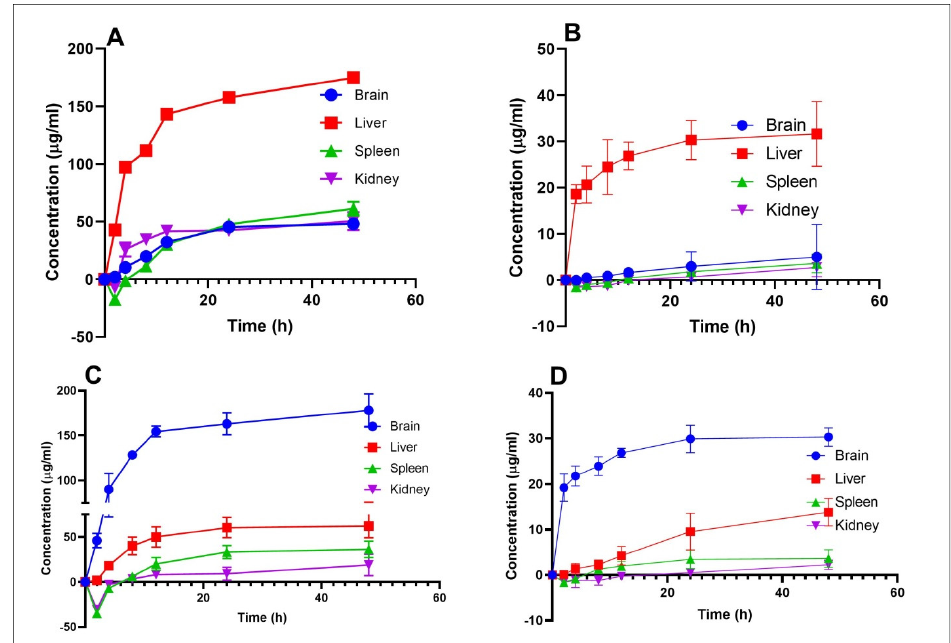
Figure 11. MeHCl and TMPS Concentration in major organs after intraperitoneal administration at 30mg/kg body weight (1:3 molar ratio) ( A ) MeHCl PD ( B ) TMPS PD ( C ) MeHCl SLN ( D ) TMPS SLN. Data are represented in mean ± SD ( n = 3).